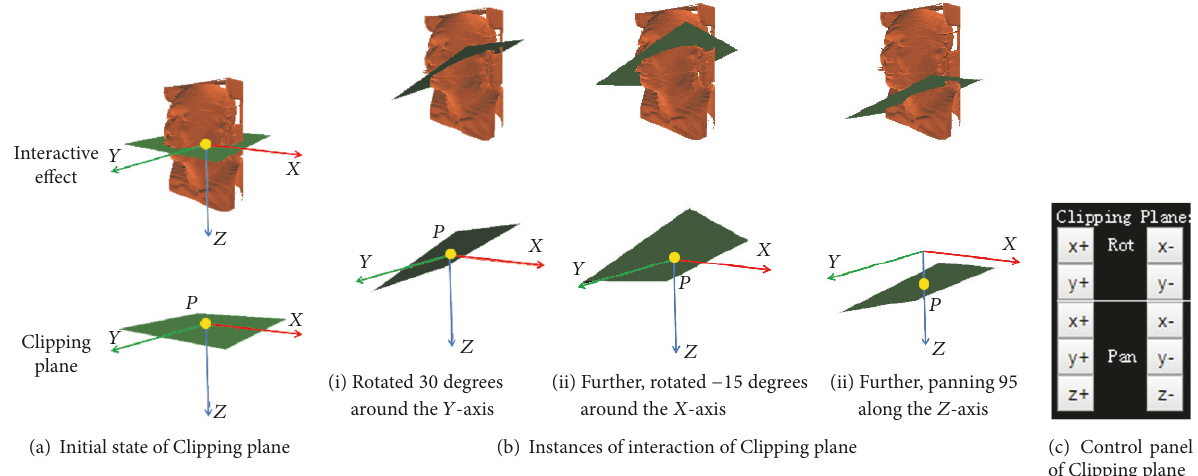
Figure 5: Design of the interaction of clipping to the Slave model and corresponding